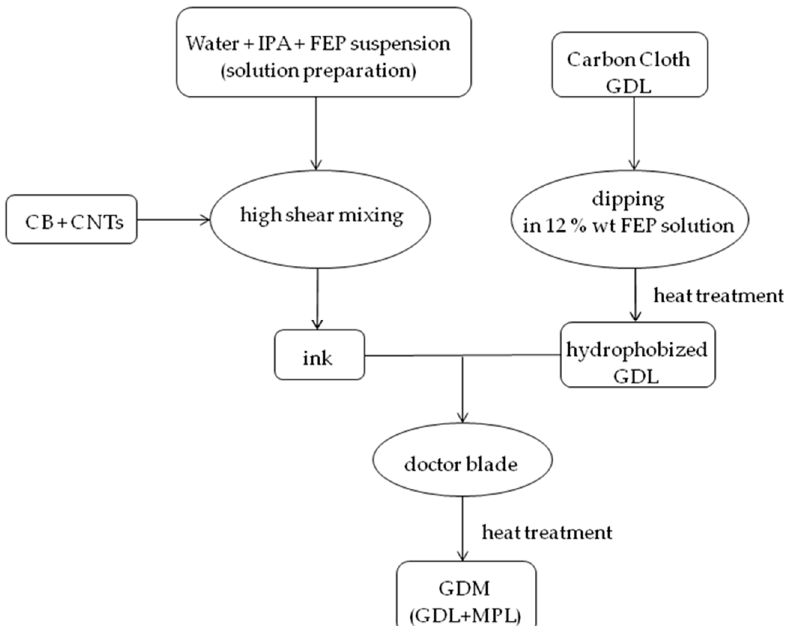
Figure 1. Schematic representation of gas diffusion medium (GDM) preparation.